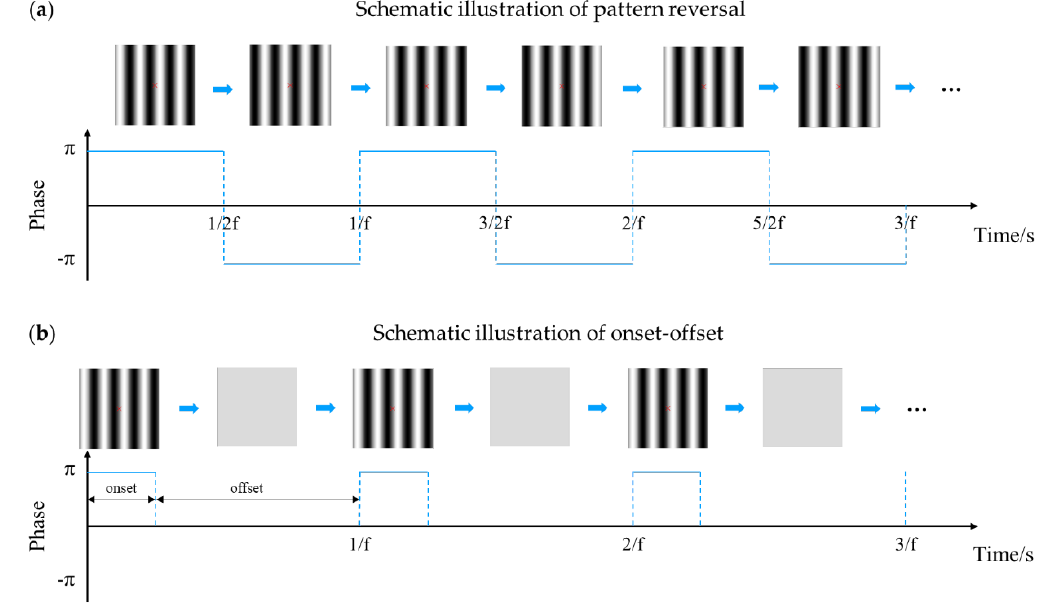
Figure 6. Schematic illustration of pattern-reversal and onset-offset stimulus modes of vertical sine- wave gratings. f, fundamental temporal frequency. ( a ) Schematic illustration of pattern reversal. ( b ) Schematic illustration of onset-offset.